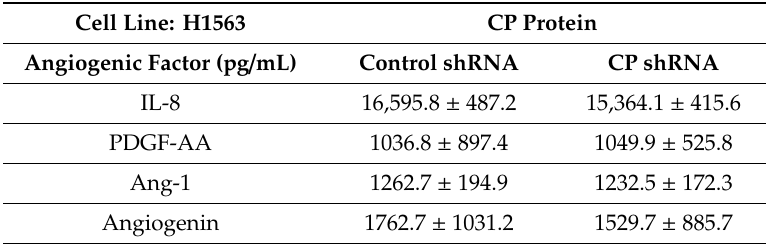
Table 1. The level of various pro-angiogenic factors in H1563 and CP-knockdown H1563